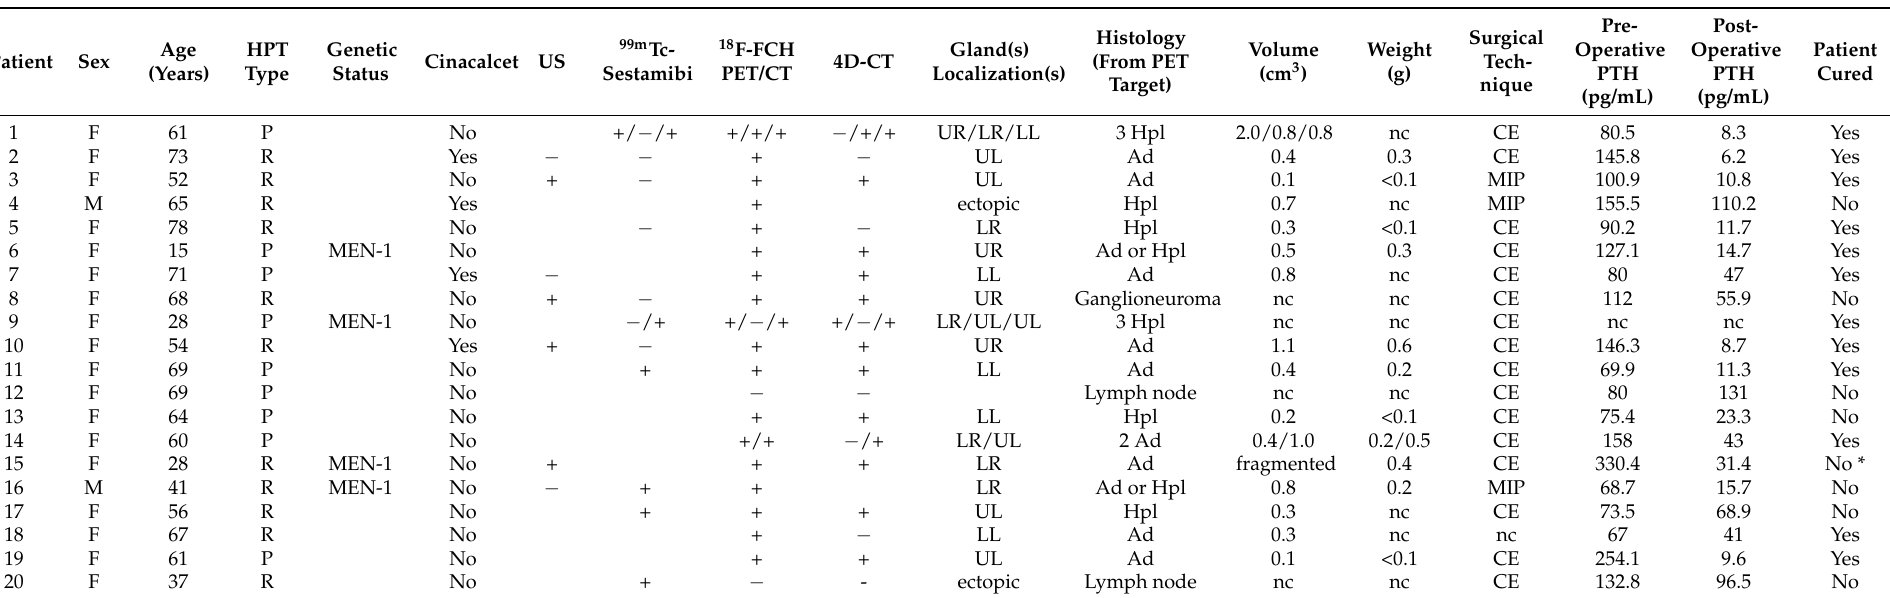
Table 2. Imaging, pathology and PTH values after second parathyroidectomy in reoperated patients after 18 F-FCH